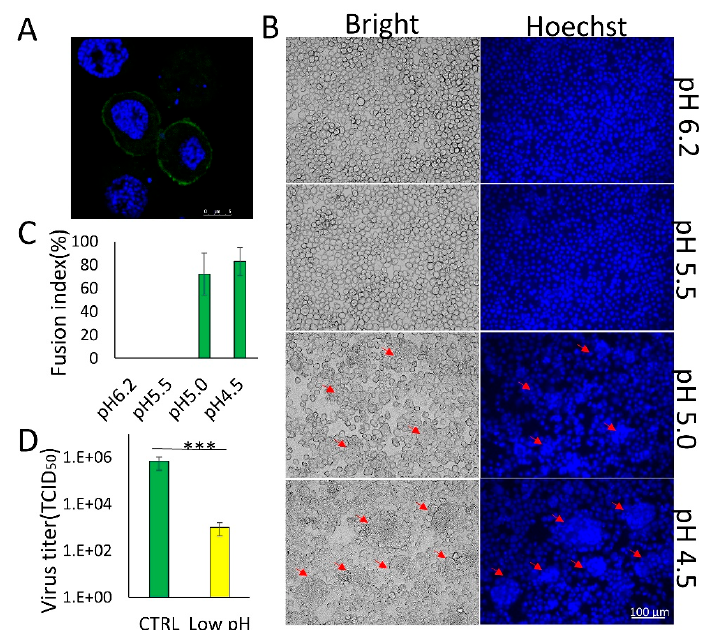
Figure 1. BmNPV is an acid-activated virus with a low triggering pH for GP64 conformational change. ( A ) Localization of BmNPV GP64 by immunofluorescence analysis with GP64 antibody and FITC-conjugated rabbit anti-mouse antibodies. Scale bar, 5 μ m. ( B ) Syncytium formation assay. BmN cells were transfected with pIZ-V5-gp64 DNA and exposed to low-pH (4.5–6.2) medium to induce syncytium formation at 72 h p.t. The arrows show the syncytia induced by the low pH. ( C ) Comparison of the fusion index of di ff erent low-pH treatments. Error bars represent standard deviations. ( D ) Reversible conformational change in BV of BmNPV. BmBac-GFP was exposed to low